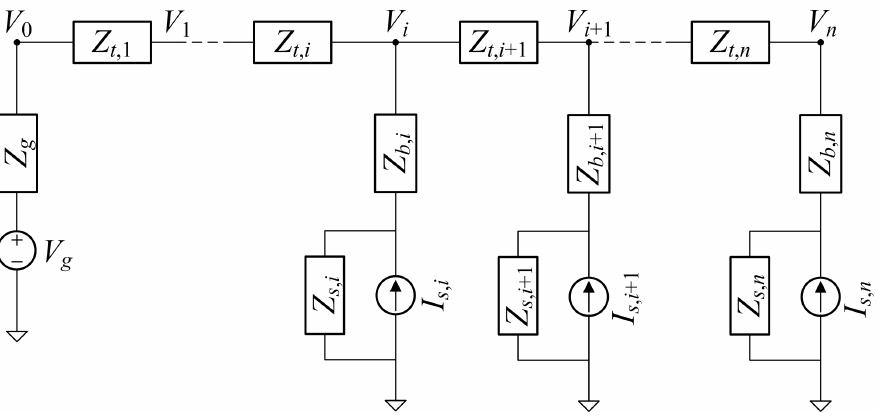
Figure 3. Ladder arrangement of the DC grid